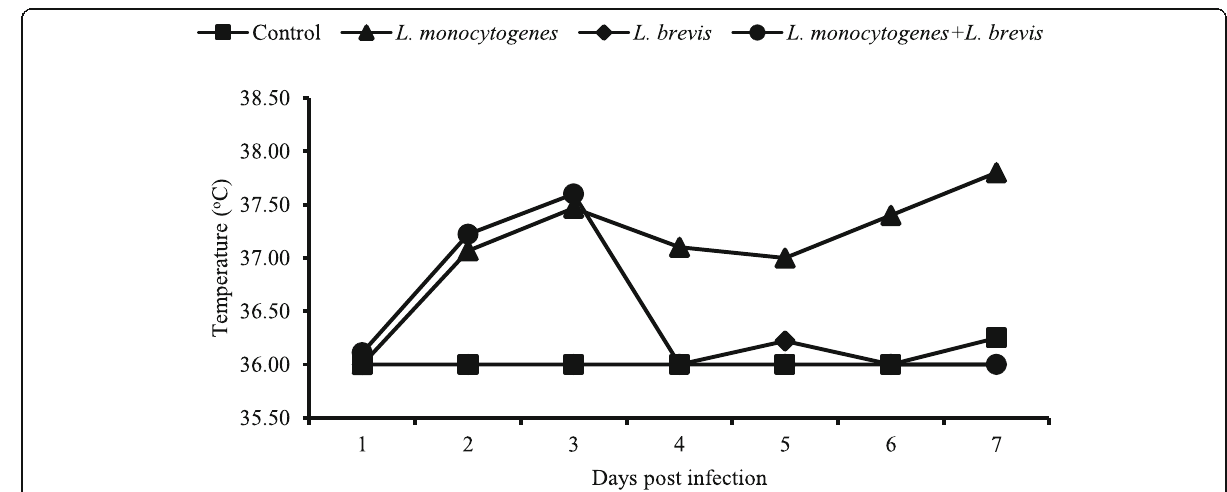
Fig. 1 Variation in body temperature among groups. Body temperature of control and L. brevis group remain steady throughout the experiment. Body temperature of LB + LM group (IV) increases up to 3 days post infection and then become equal to control group. While body